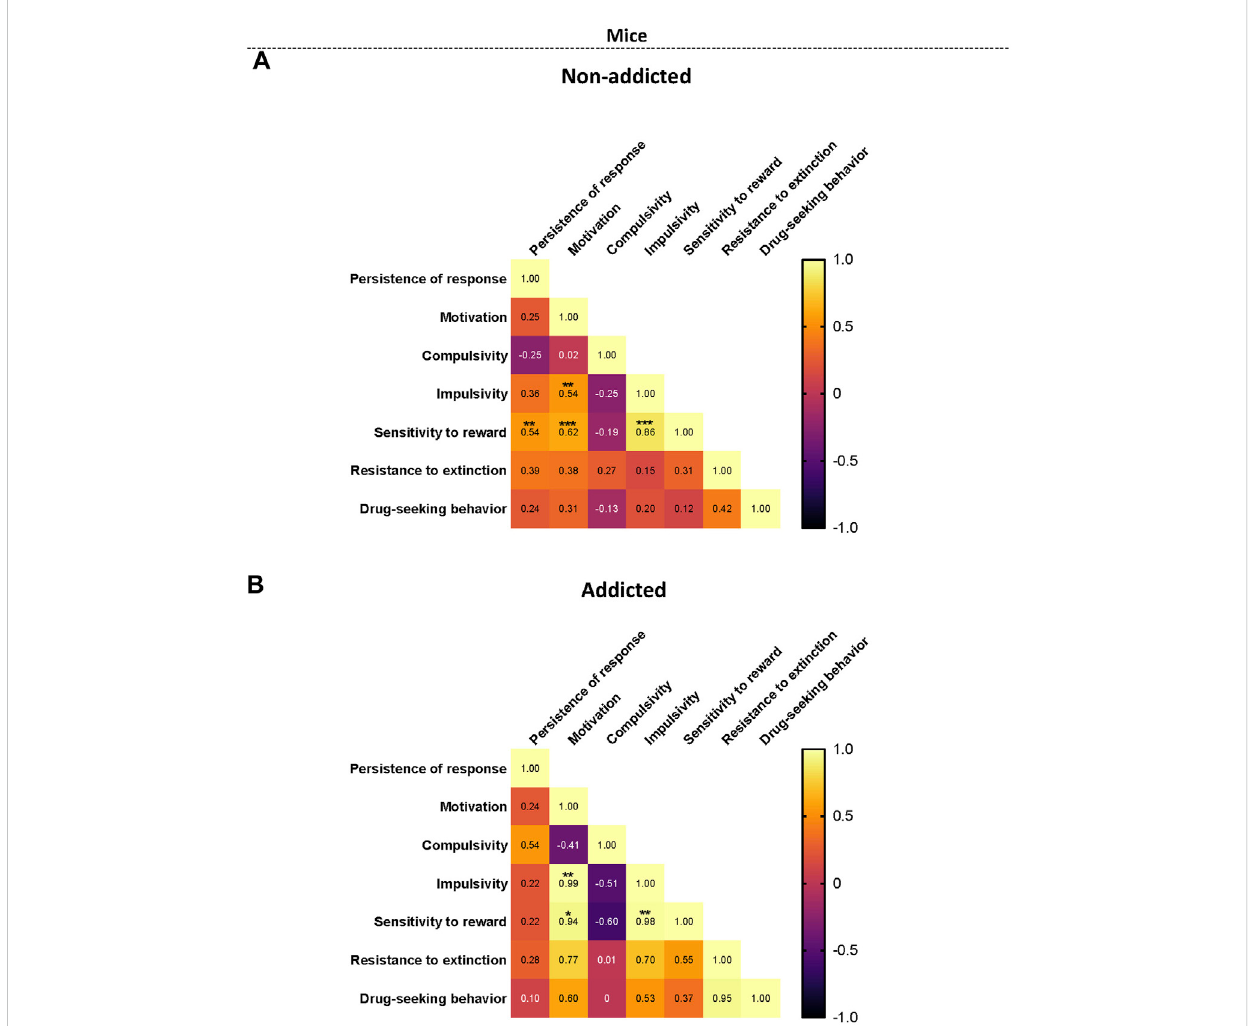
Correlation heatmaps of the variables of cannabinoid addiction criteria, parameters related to craving, and phenotypic vulnerability traits. (A – B) Pearson correlations between the three addiction-like criteria, the two parameters related with craving and the two phenotypic traits in both (A)